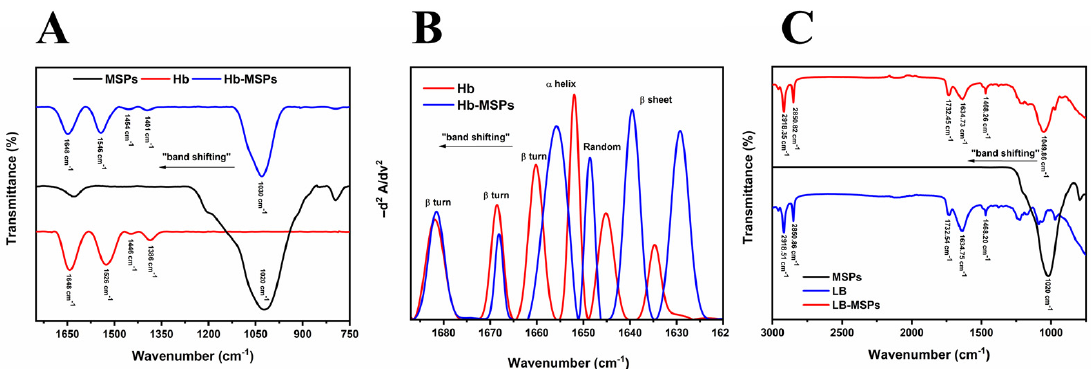
Figure 7. ( A , C ) Fourier transform infrared spectra of heulandite − Ca MSPs ( A , C ), and free Hb and Hb − loaded MSPs ( A ), and empty liposomes and liposome − encapsulated MSPs ( C ). ( B ) Curve − fitting of the inverted second − derivate spectra of the amide I region of Hb and Hb − loaded MSPs.